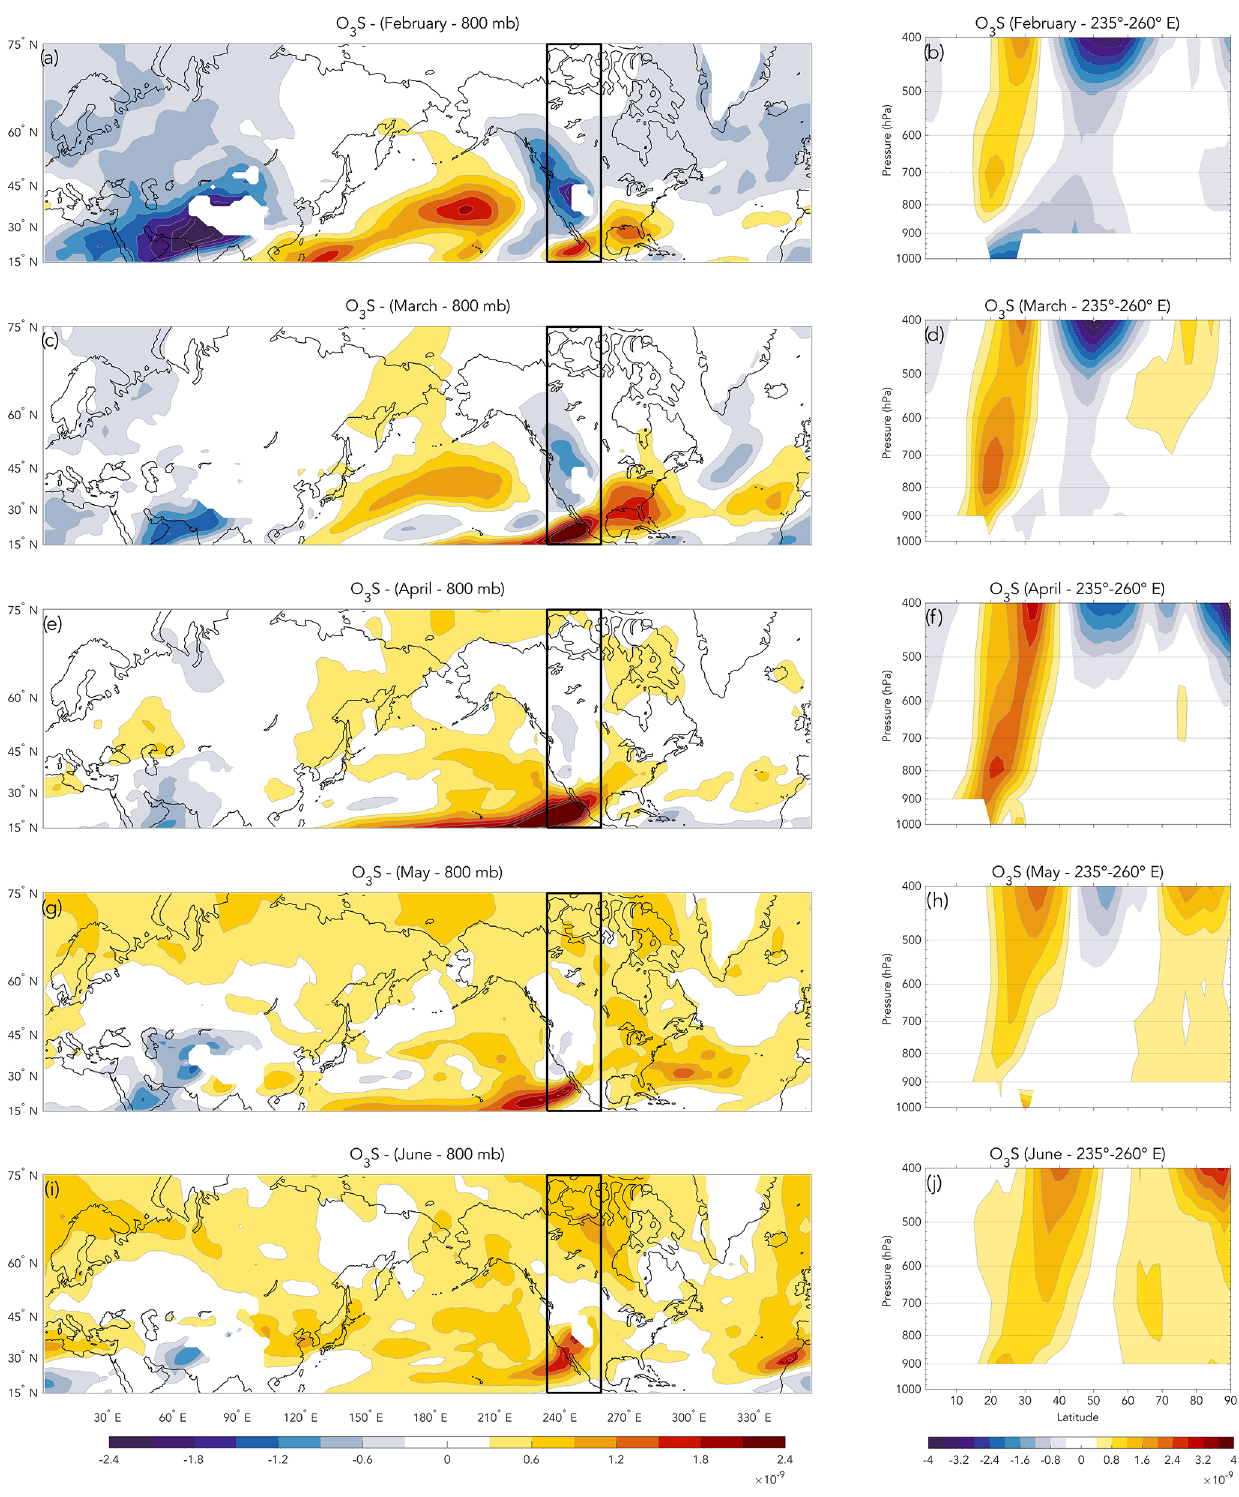
Figure 8. February–June El Niño composites of (a, c, e, g, i) 800hPa O 3 S anomalies and (b, d, f, h, j) zonal mean anomaly cross-sections of O 3 S where the longitudinal boundaries (235–260 ◦ E) of the zonal mean correspond to the box overlaying the left column composites and all figures in the left column are shown on the 800mbar pressure surface. All units are the mass mixing ratio. White areas reflect missing data associated with